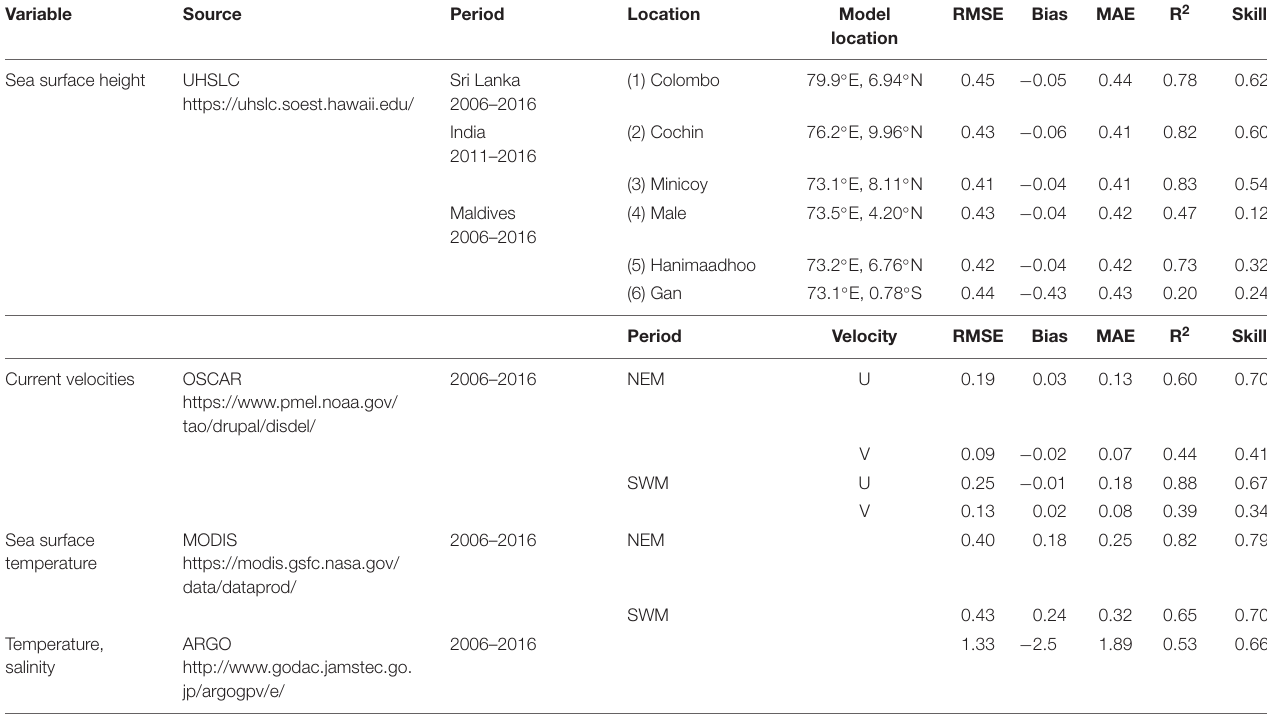
TABLE 1 | Observational data sets used for model validation and statistical